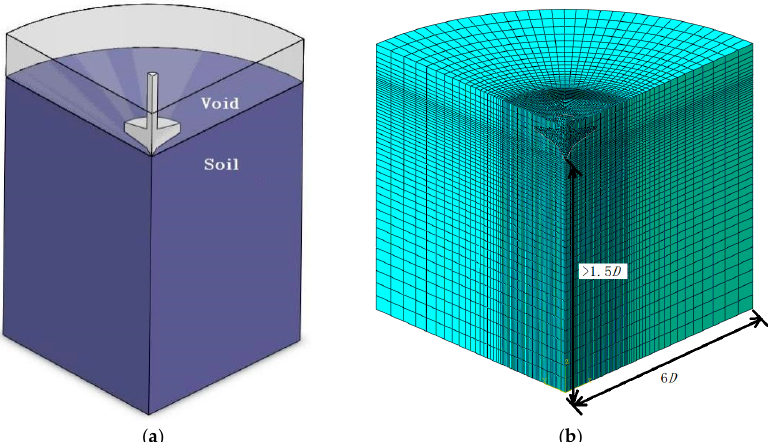
Figure 2. Diagram of the quarter symmetric CEL model: ( a ) Schematic diagram; ( b ) Mesh. During each incremental step of the CEL approach, an updated Lagrangian calcula-